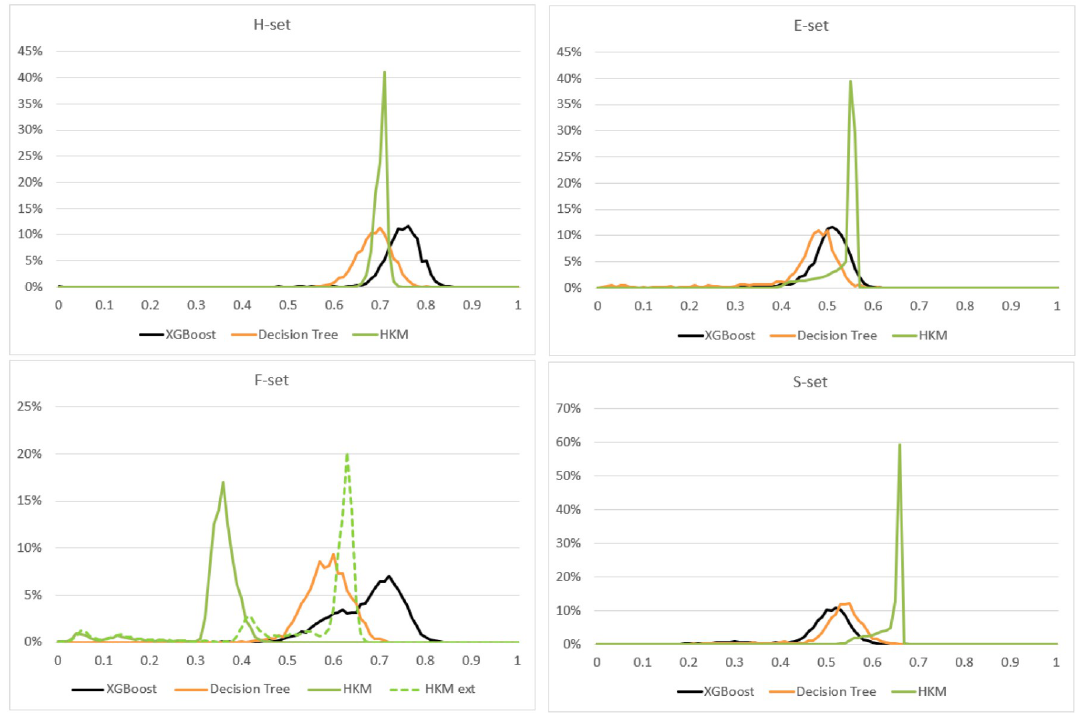
Fig 3. Distribution of F 1 values for HKM, decision tree, and XGBoost models on four different datasets where they were trained.